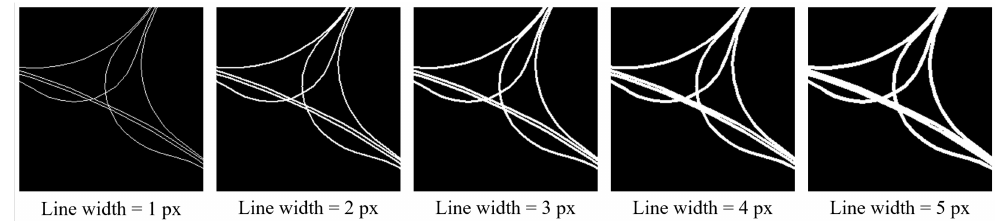
Figure 3. Comparison of the raster images generated with different line